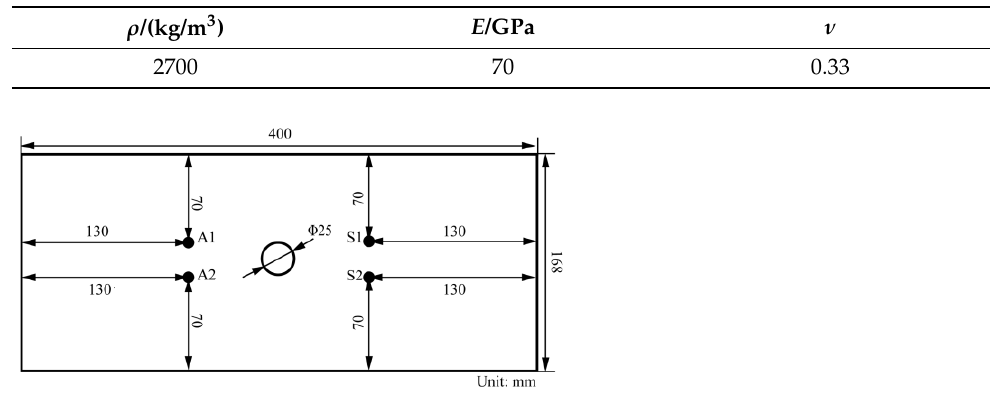
Figure 4. FE model of center-hole metal specimen using ABAQUS/Explicit.